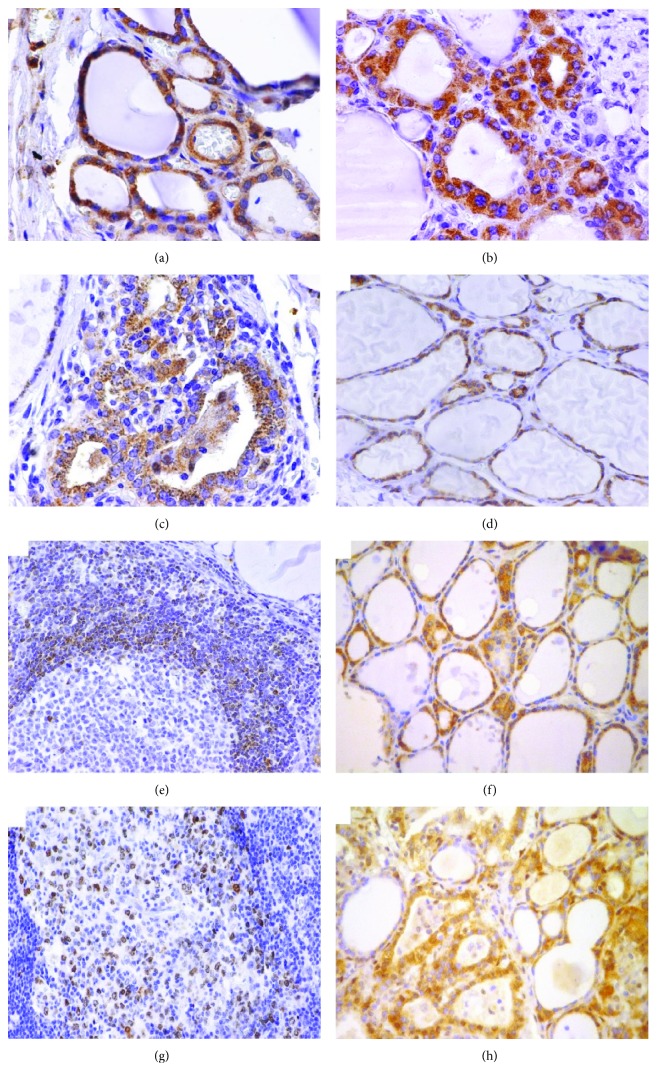
Expression of markers in thyroid specimens. (a) Fas (×40); (b) FasL (×40); (c) BID (×40); (d) BCL2 (×10); (e) BCL2 in intrathyroidal secondary lymphoid follicle (×40); (f) MCL1 (×10); (g) Ki67 in intrathyroidal secondary lymphoid follicle (×40); (h) p27Kip1 (×10).